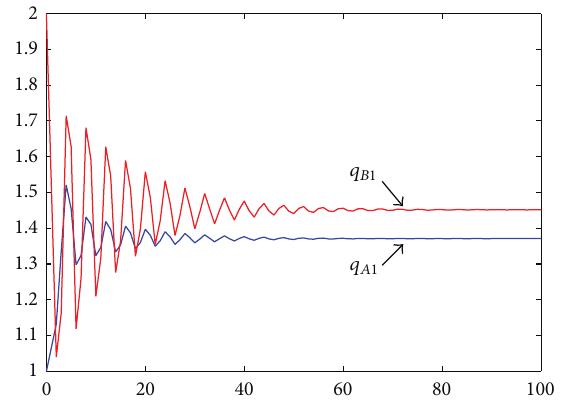
Figure 7: Evolution for the dynamic system (26) with the control- ling factor 𝑘 = 1.5 .